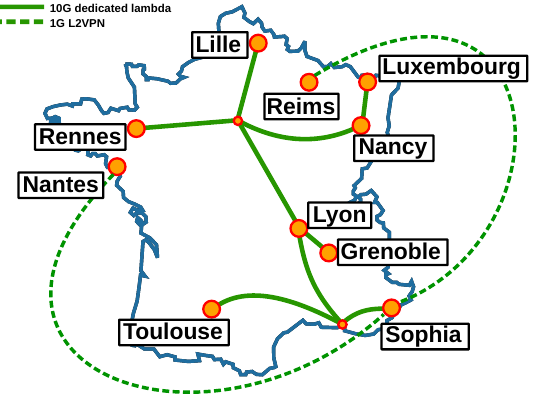
Figure 2: Map of the 10 sites of the Grid’5000